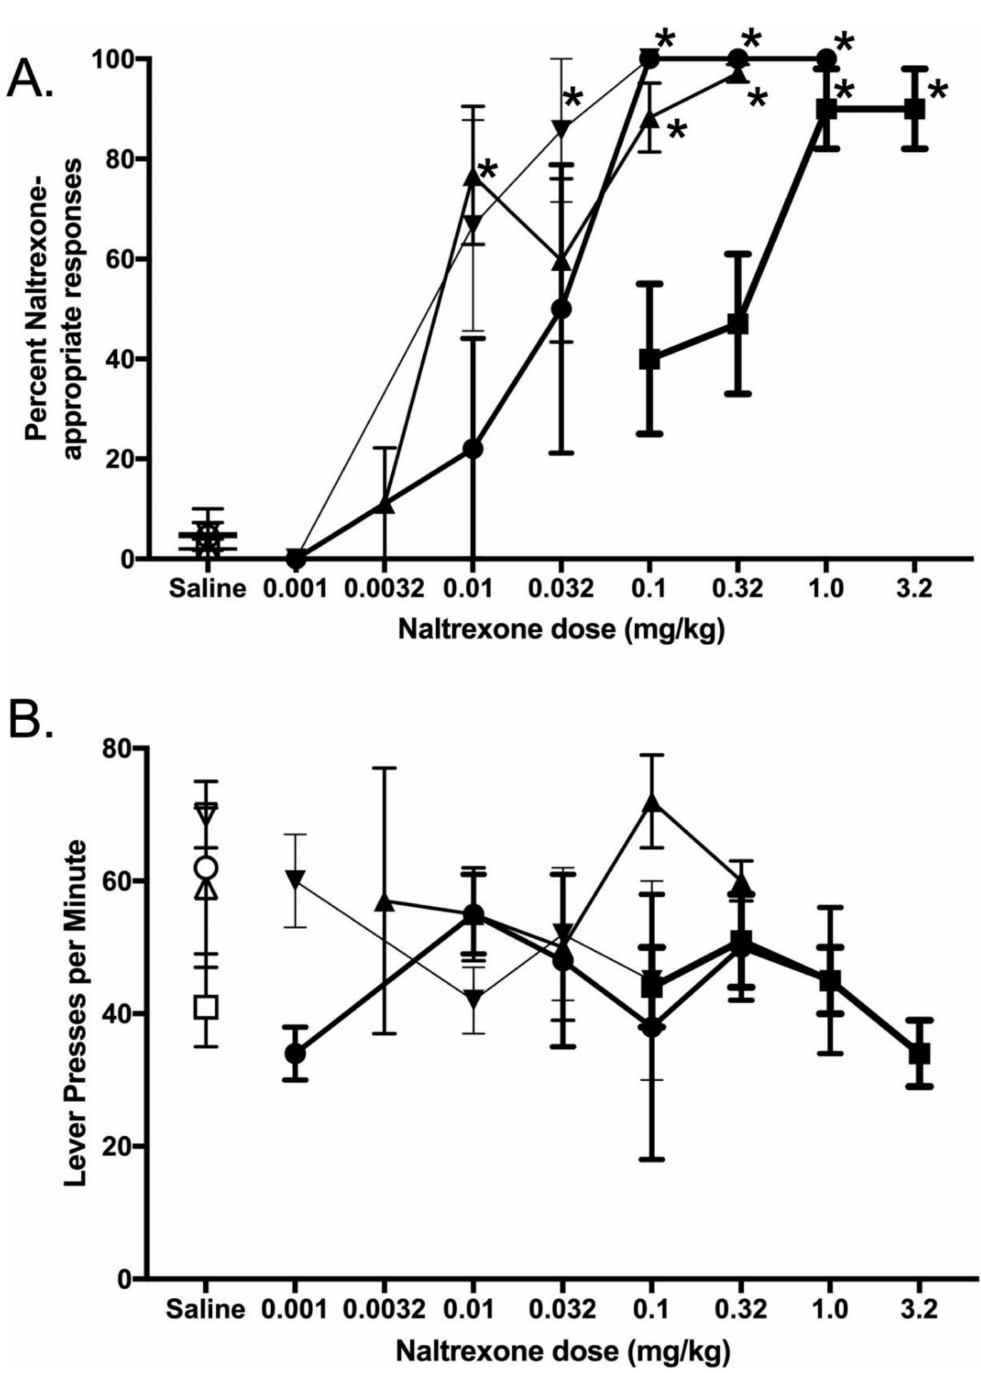
Figure 3. NTX dose-effect curves are depicted as a function of training dose (0.1 mg/kg NTX inverted triangle, 0.32 mg/kg NTX triangle, 1.0 mg/kg NTX circle, and 3.2 mg/kg NTX square). ( A ) NTX generalization curves as a function of naltrexone training dose. The percentage of responses associated with the NTX training dose is plotted on the ordinate. ( B ) Response rate (lever presses per minute) is plotted as a function of NTX dose. * = p < 0.05 (significantly different than saline